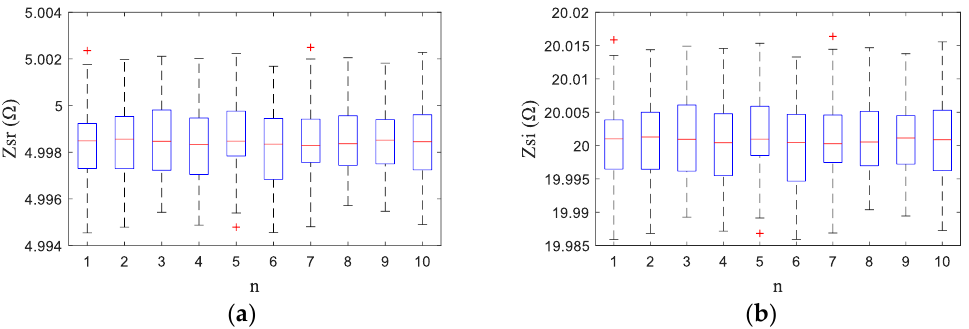
Figure 12. Results of method 4 in simulation II. ( a ) Result of real part; ( b ) Result of imaginary part.